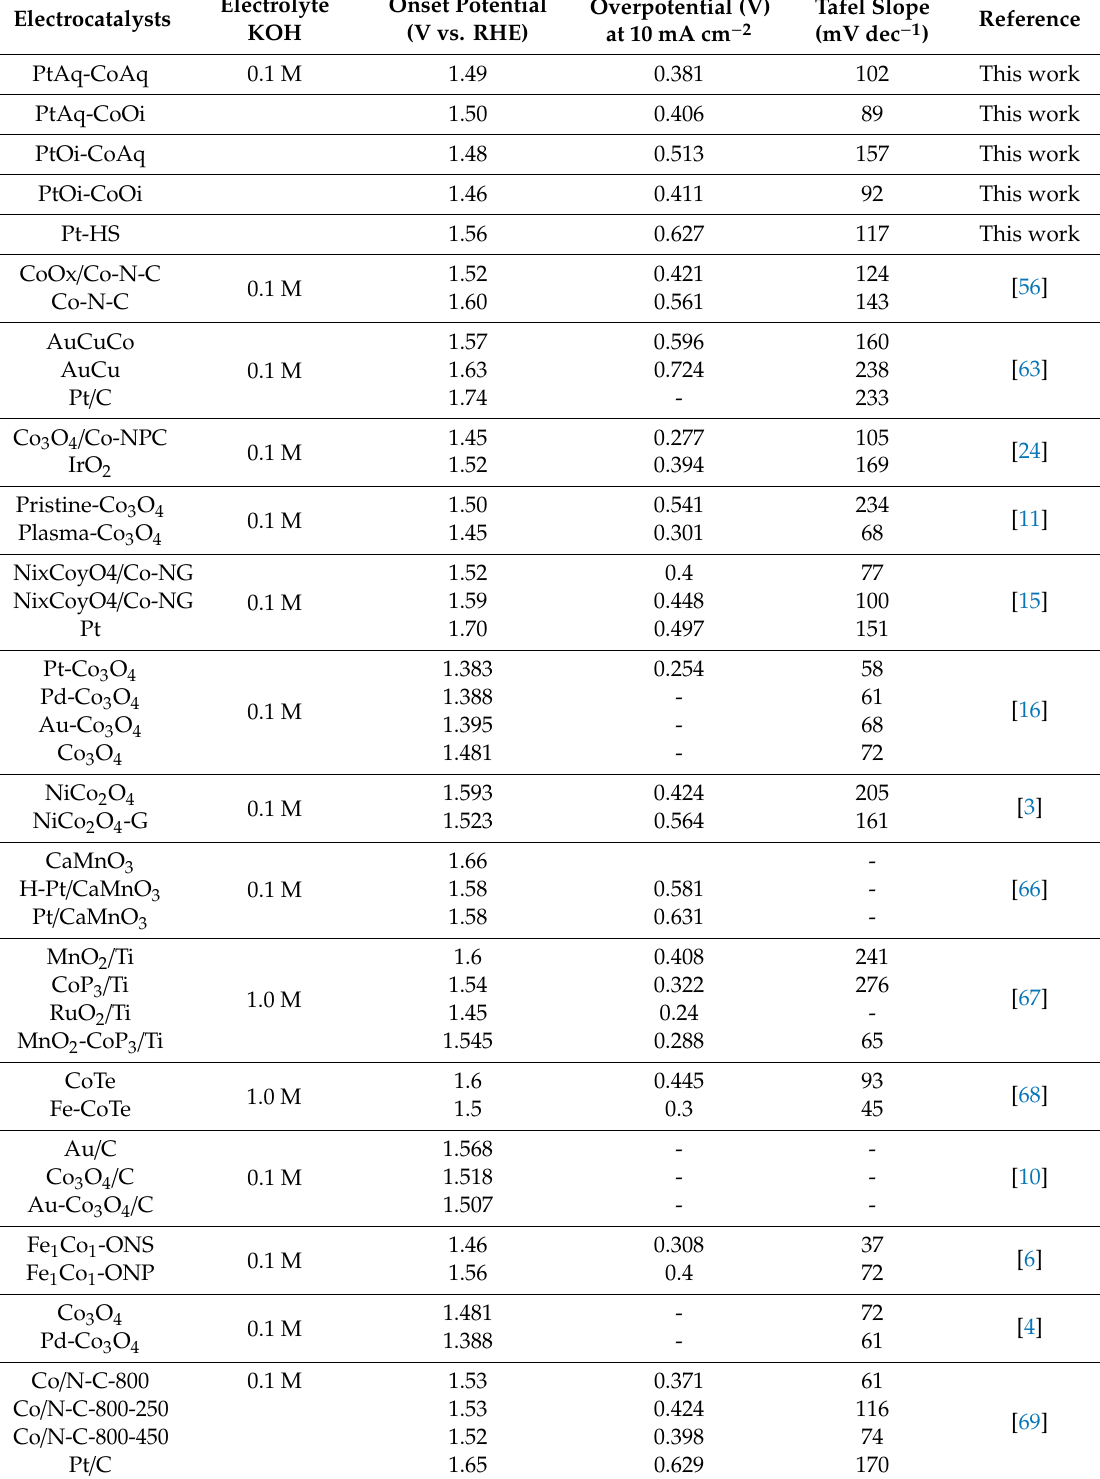
Table 3. Comparison of the Pt-Co 3 O 4 -HSs and Pt-HS electrocatalysts synthesized in this work versus reported